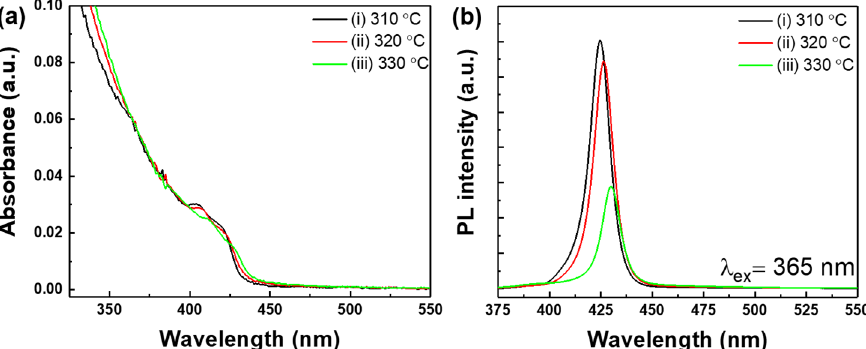
Figure 3. ( a ) Absorption and ( b ) PL spectra of the ZnSe/ZnS C/S QDs synthesized at (i) 310 ℃ , (ii) 320 ℃, and (iii) 330 ℃ , respectively.